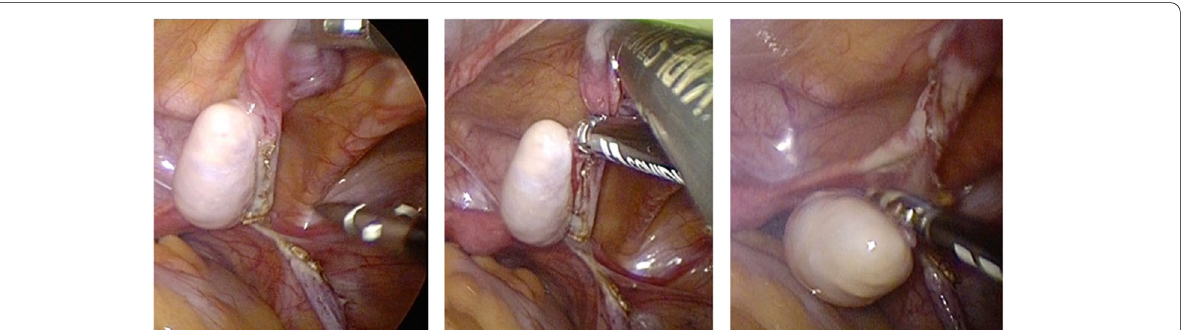
Fig. 2 SILS dissection—note the ‘crossover’ of instruments with the Ligasure appearing on the left of the screen but held in the surgeon’s right